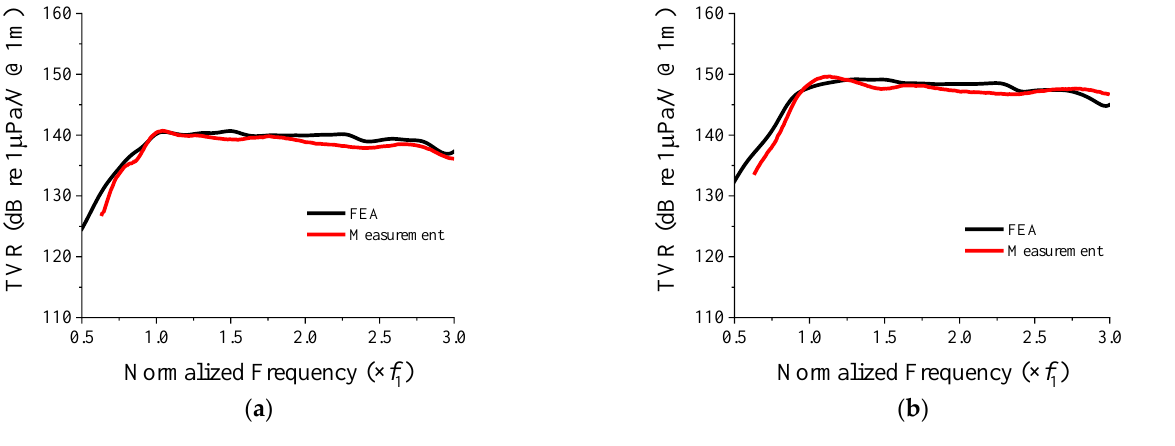
Figure 21. Comparison between measured and calculated TVR spectra of the two-layered cymbal arrays: ( a ) 3 × 3 array; ( b ) 5 × 5 array.